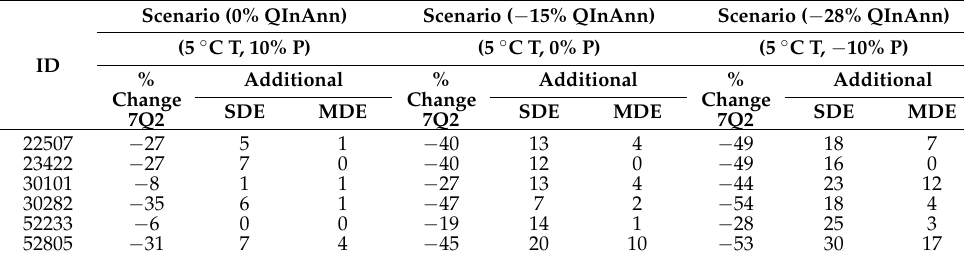
Table 4. Performance of low flow conditions under mid flow conditions: compensatory, changing, and critical, respectively. The additional SDE and MDE columns are the additional number of events concerning the number of current events (shown in Table 3). QInAnn: interannual mean